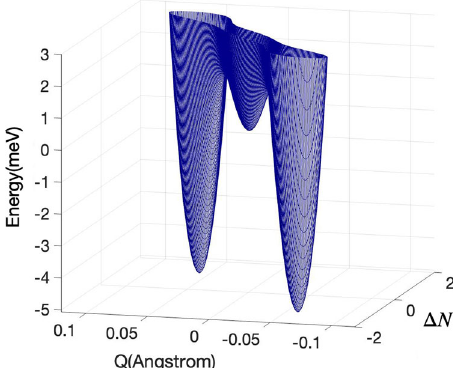
Fig. 1 Energy Landscape for NdNiO 3 as a function of the electronic and ionic lattice disproportionation. Energy landscape for NdNiO 3 as a function of electronic disproportionation Δ N and lattice distortion (bond disproportionation) Q as obtained from the energy functional methods introduced in this paper using data from ref. 4